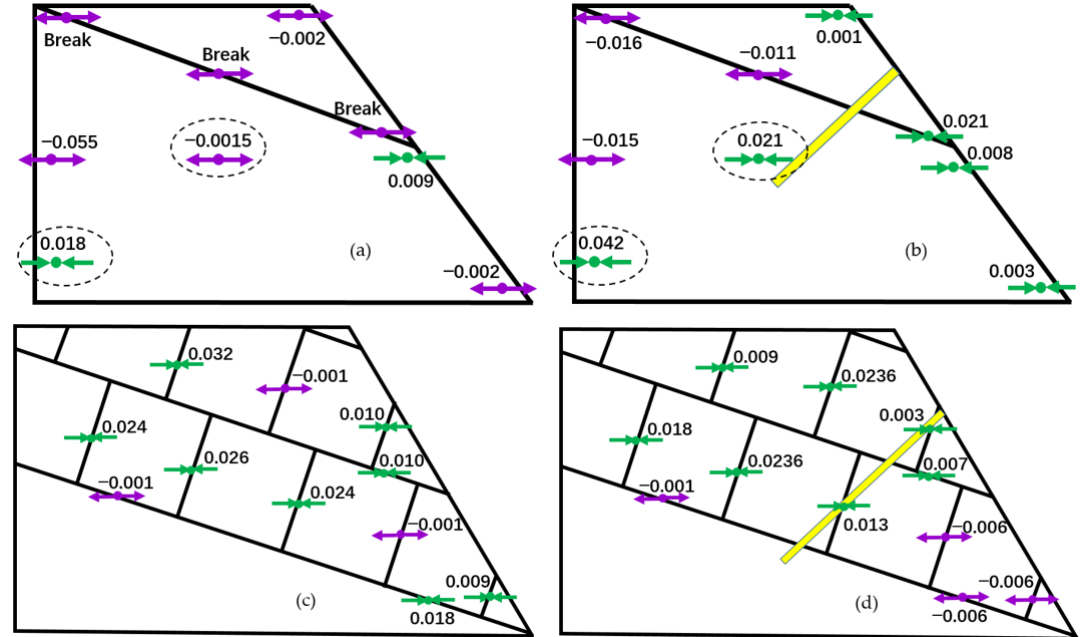
Figure 15. Strain values of the slope model after reinforcement under loading and irrigation. ( a ) One crack at 20°; ( b ) one crack at 20° strengthened with an anchor stock; ( c ) crack networks at 20°; ( d ) crack networks at 20° strengthened with an anchor stock.